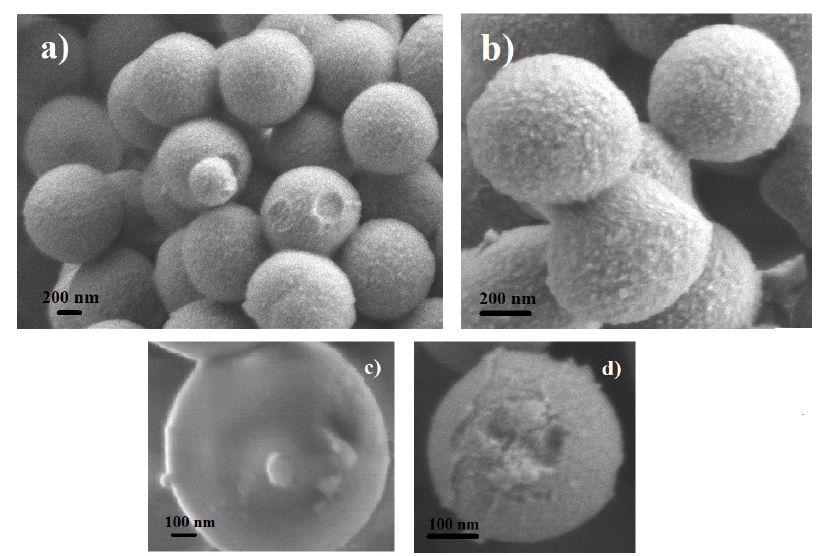
Figure 2. SEM images of SFT-Ag-PMA SiO 2 capsules showing a porous structure ( a , b ), a smooth surface ( c ) and a layered composition ( d